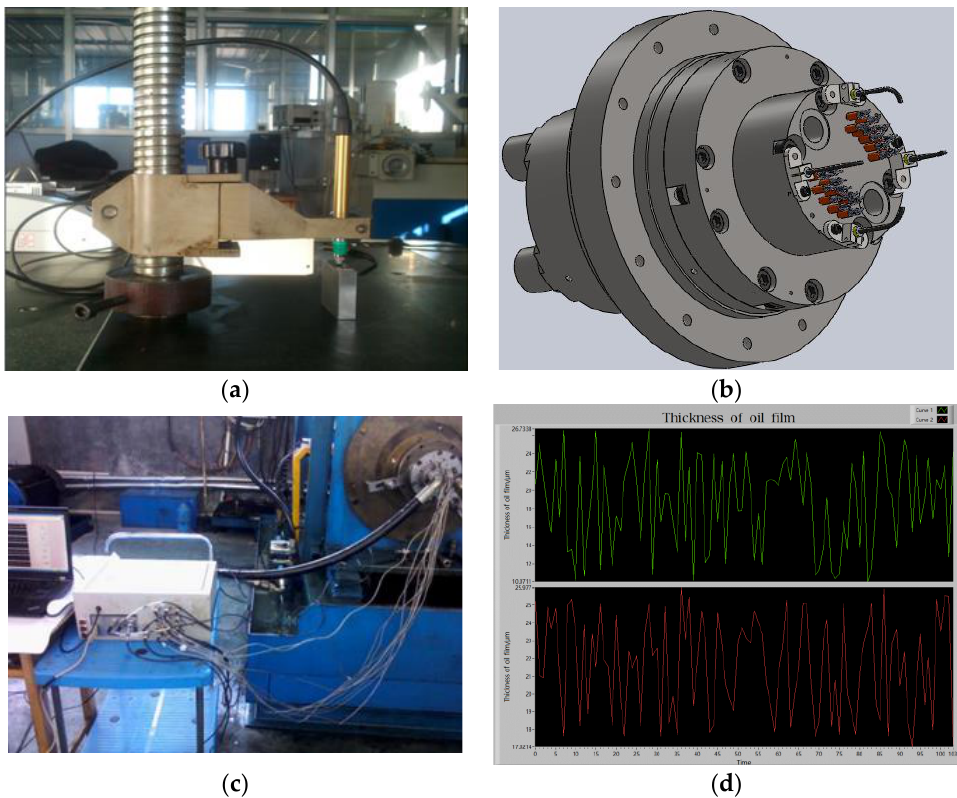
Figure 20. The oil film thickness measurement device of the port plate pair. ( a ) Device for calibrating the micro displacement sensor; ( b ) three-dimensional view of the oil film thickness test; ( c ) oil film thickness testing device; ( d ) oil film thickness test interface.